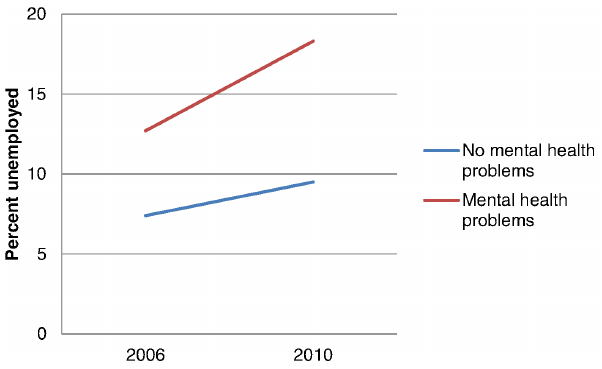
Figure 1. Average unemployment rates among individuals in Eurobarometer 2006 and 2010, stratified by presence of mental health problems (aged 18–65).